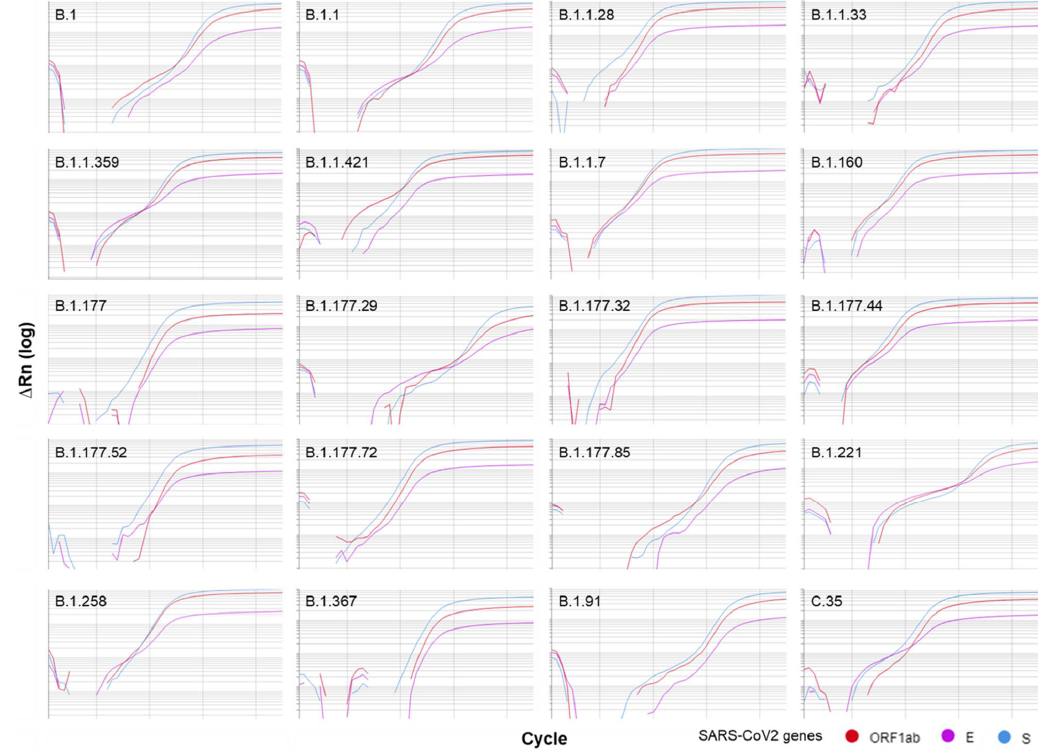
Figure 4. OmnisSARS2 detects different SARS-CoV-2 lineages. Representative qRT-PCR amplification plots showing the successful detection of the E, ORF1ab and S viral genes in nasopharyngeal samples from individuals infected with SARS-CoV-2 viruses from 20 different viral lineages.